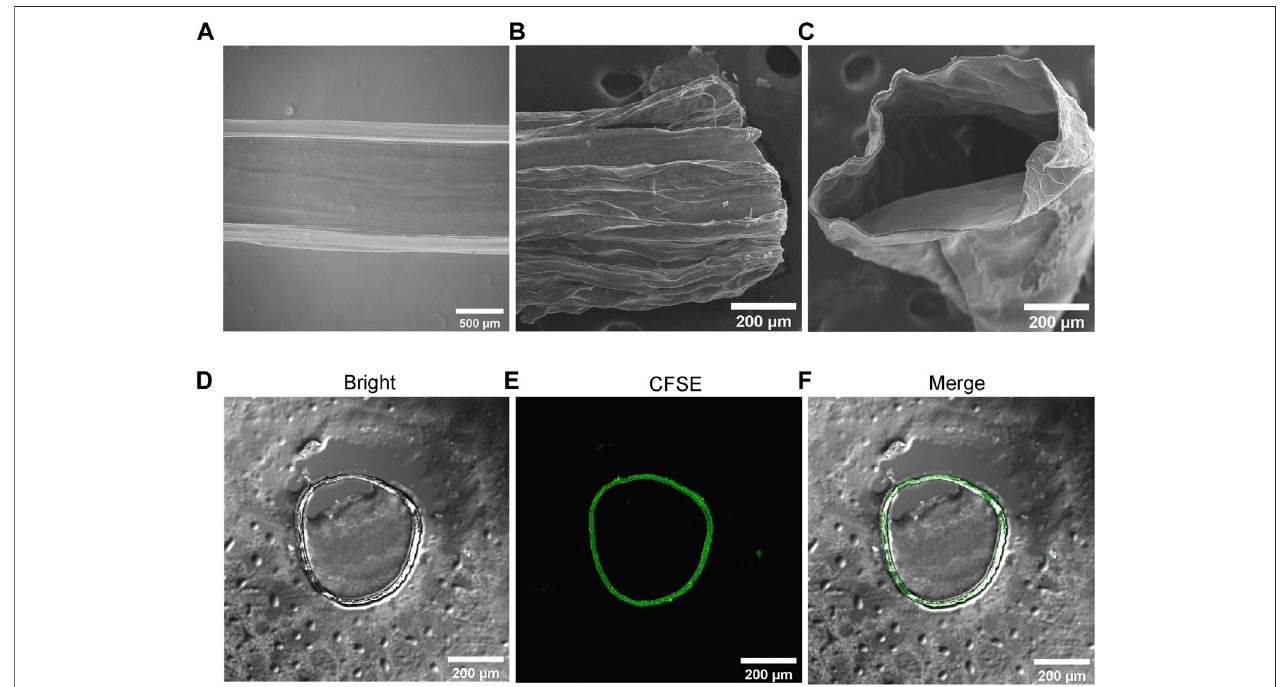
FIGURE3| StructureCharacterizationofHydrogelMicrotubes (A) Themicroscopicimageofmicrotube,thescaleis500 μ m;SEMimageof (B) longitudinalsection and (C) cross-section of the microtubule, the scale is 200 μ m (D – F) The cross-section of hollow microtubes was observed with CLSM, after adding microspheres with green fl uorescence to the microtubes, the scale is 200 μ